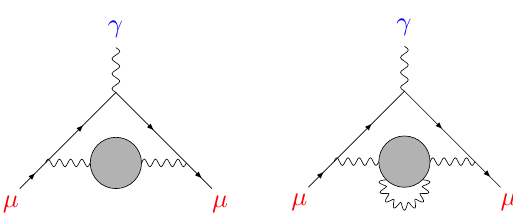
Figure 1 . Different hadronic contributions to ( g − 2) µ : leading-order HVP (left), e.m. corrections to leading-order HVP (right). The blob represents the contribution from QCD